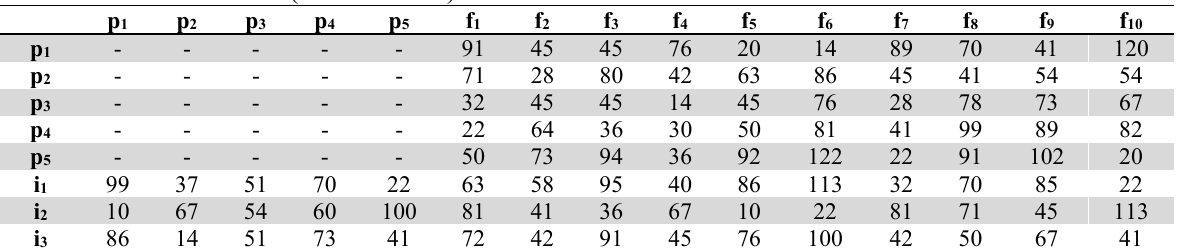
Distances between nodes (in kilometers)